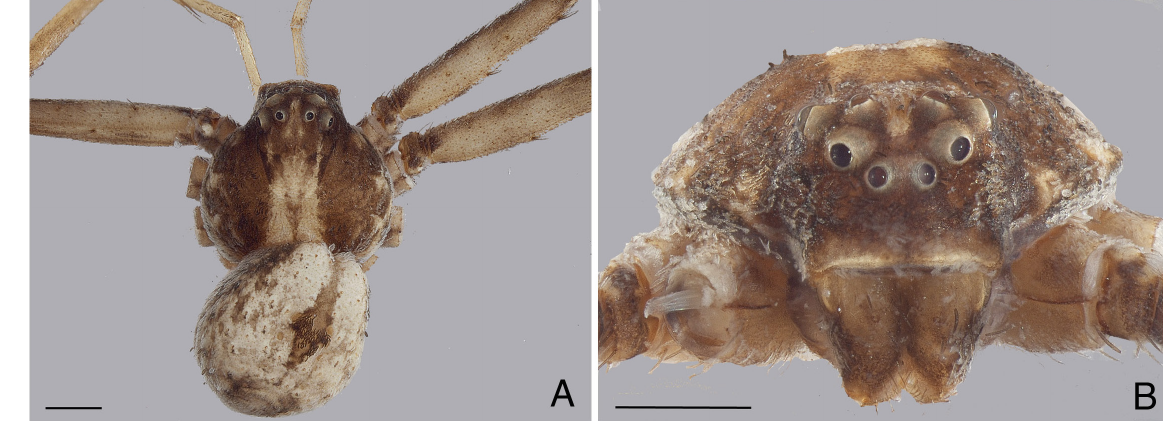
Fig. 10. Apollophanes (?) lonesomegeorgei sp. nov. A . ♂ prosoma, dorsal view. B . ♂ prosoma, frontal view (AM and AL eyes). Scale bars: 0.5 mm. Photographs by Rudy